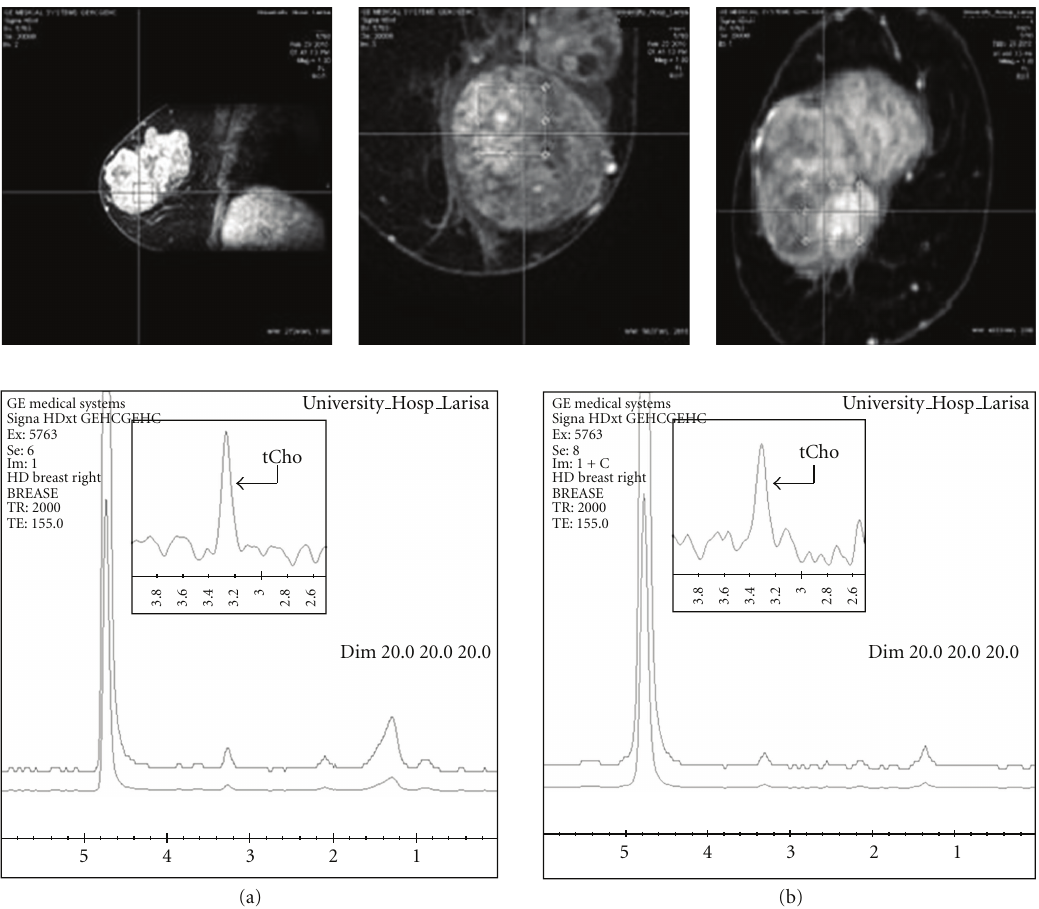
Figure 1: Breast MR spectra of a 60-year old patient, before (a) and 8min after (b) contrast injection using a voxel of 14.7 ∗ 16.8 ∗ 15 cm 3 . The relative tCho peak intensity decreases, and line-width broadening in the postcontrast spectra is clearly